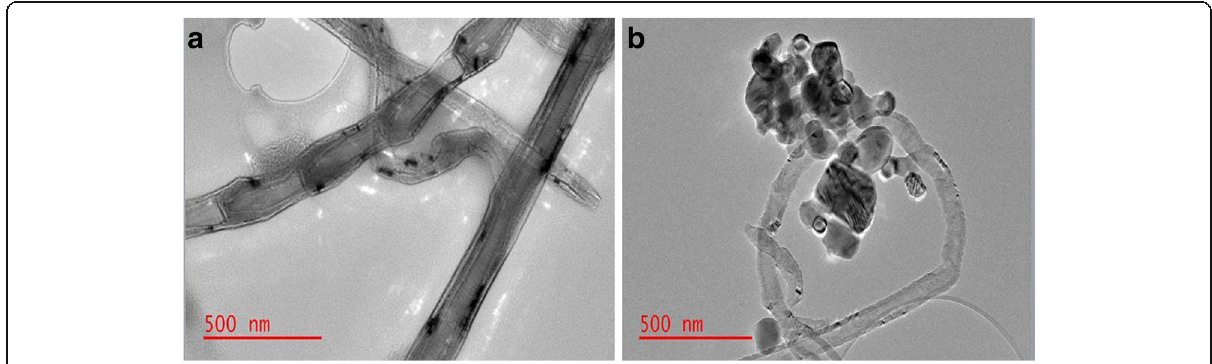
Fig. 5 TEM images of a CNFs and b ZnO-MgO@CNFs taken at 500